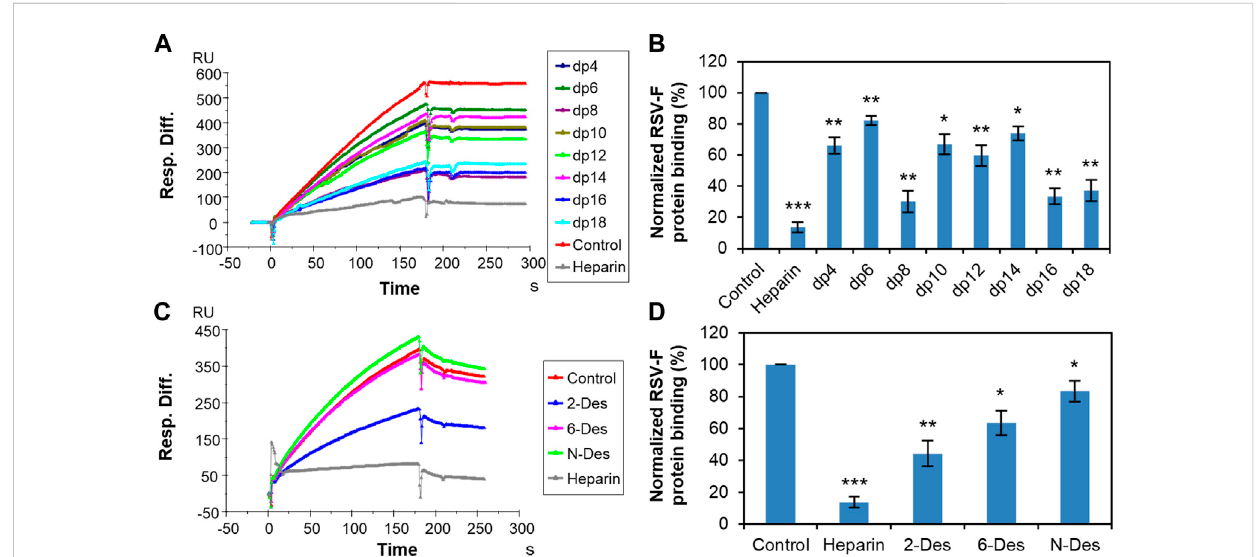
FIGURE 3 RSV-F protein – heparininteraction inhibited byheparinoligosaccharides or desulfatedheparins using solution competition. (A) SPR sensorgrams of RSV-F protein – heparin interaction competing with different heparin oligosaccharides. Concentration of RSV-F protein is 40 nM mixed with 1,000 nM of different heparin oligosaccharides. (B) Bar graphs (based on triplicate experiments with standard deviation) of normalized RSV-F protein binding to surface-immobilized heparin by competing with different heparin oligosaccharides. (C) SPR sensorgrams of RSV-F protein – heparin interaction competing with different desulfated heparins. Concentration of RSV-F protein is 40 nM mixed with 1,000 nM of different desulfated heparins. (D) Bar graphs(basedontriplicateexperimentswithstandarddeviation) ofnormalizedRSV-Fproteinbindingtosurface-immobilizedheparinbycompetingwith different desulfated heparins. Statistical analysis was performed using unpaired two-tailed t -test (*: p ≤ 0.05 compared to the control, **: p ≤ 0.01 compared to the control, ***: p ≤ 0.001 compared to the